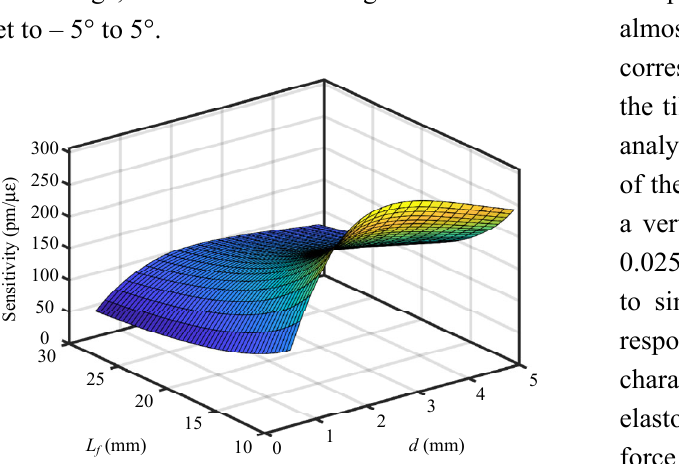
Fig. 5 Relationship between the sensitivity and parameters, L and d . f Table 1 Key parameters.